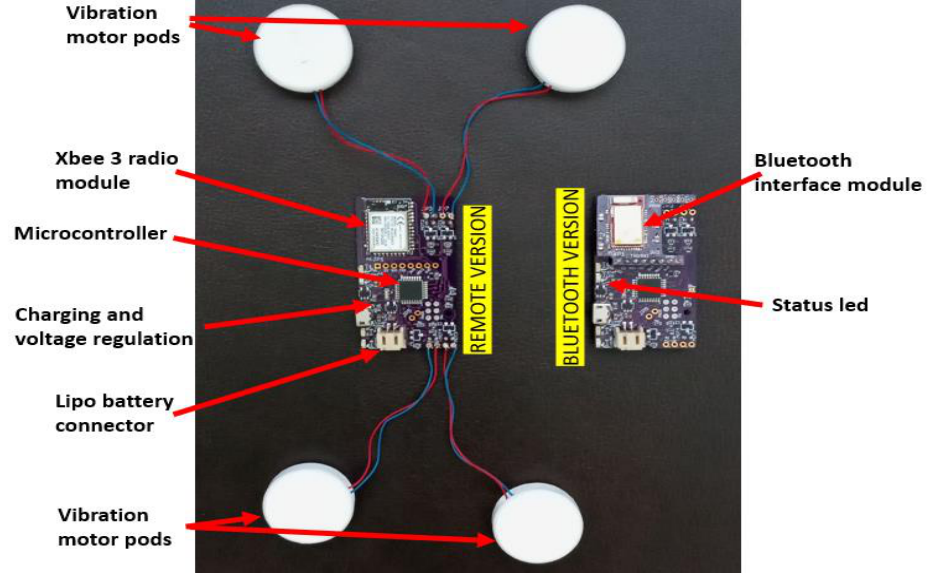
Figure 2. Electronics design of FoVi. Elements of the control electronics box are shown with con- nected motors. All the elements are on a custom-printed circuit board. motors. All the elements are on a custom-printed circuit